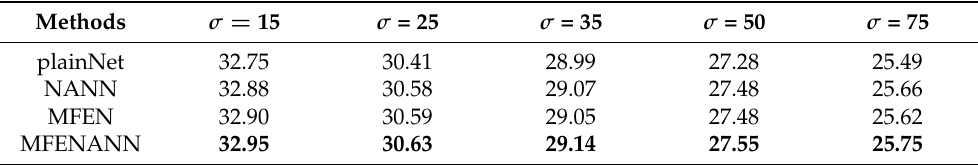
Table 1. Average PSNR (dB) values for images in “Set12” restored by plainNet, NANN, MFEN and MFENANN at noise levels of 15, 25, 35, 50 and 75. The bold numbers are the largest ones at each corresponding noise